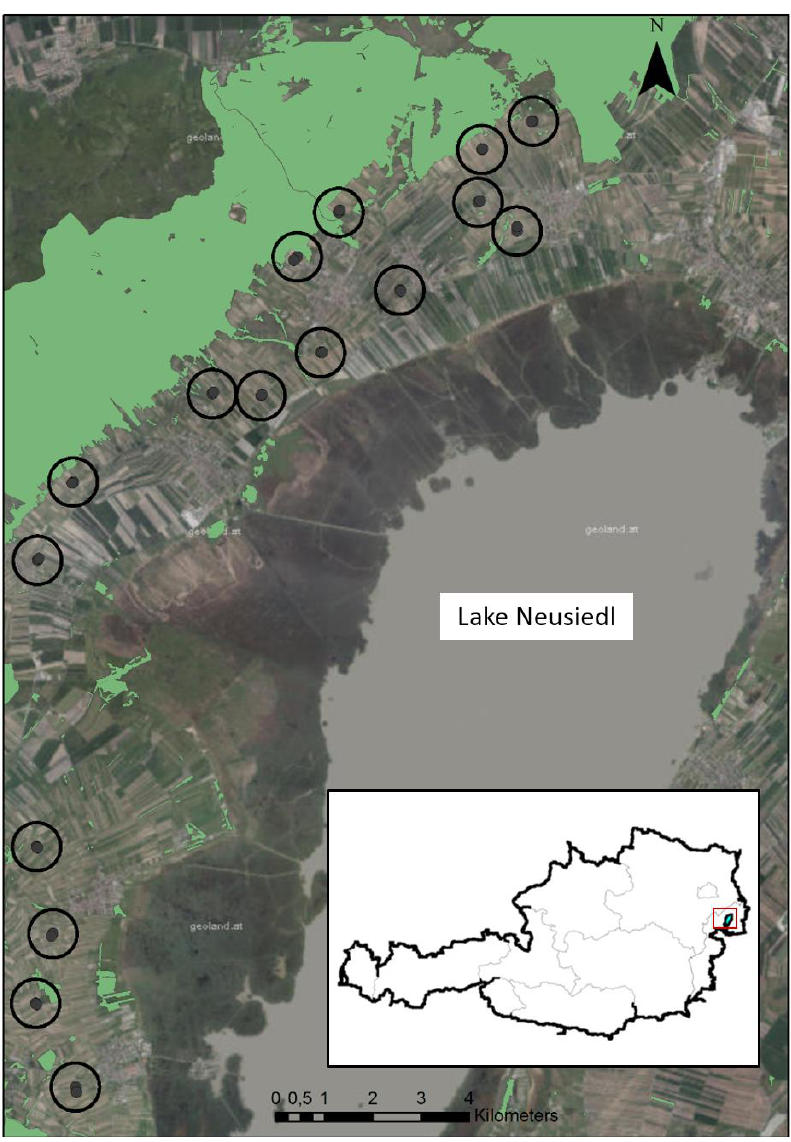
Figure 1. Study sites in eastern Austria.